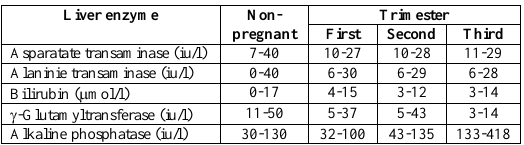
Normal ranges for liver enzymes in non-pregnant and pregnant populations (reproduced with permission 16